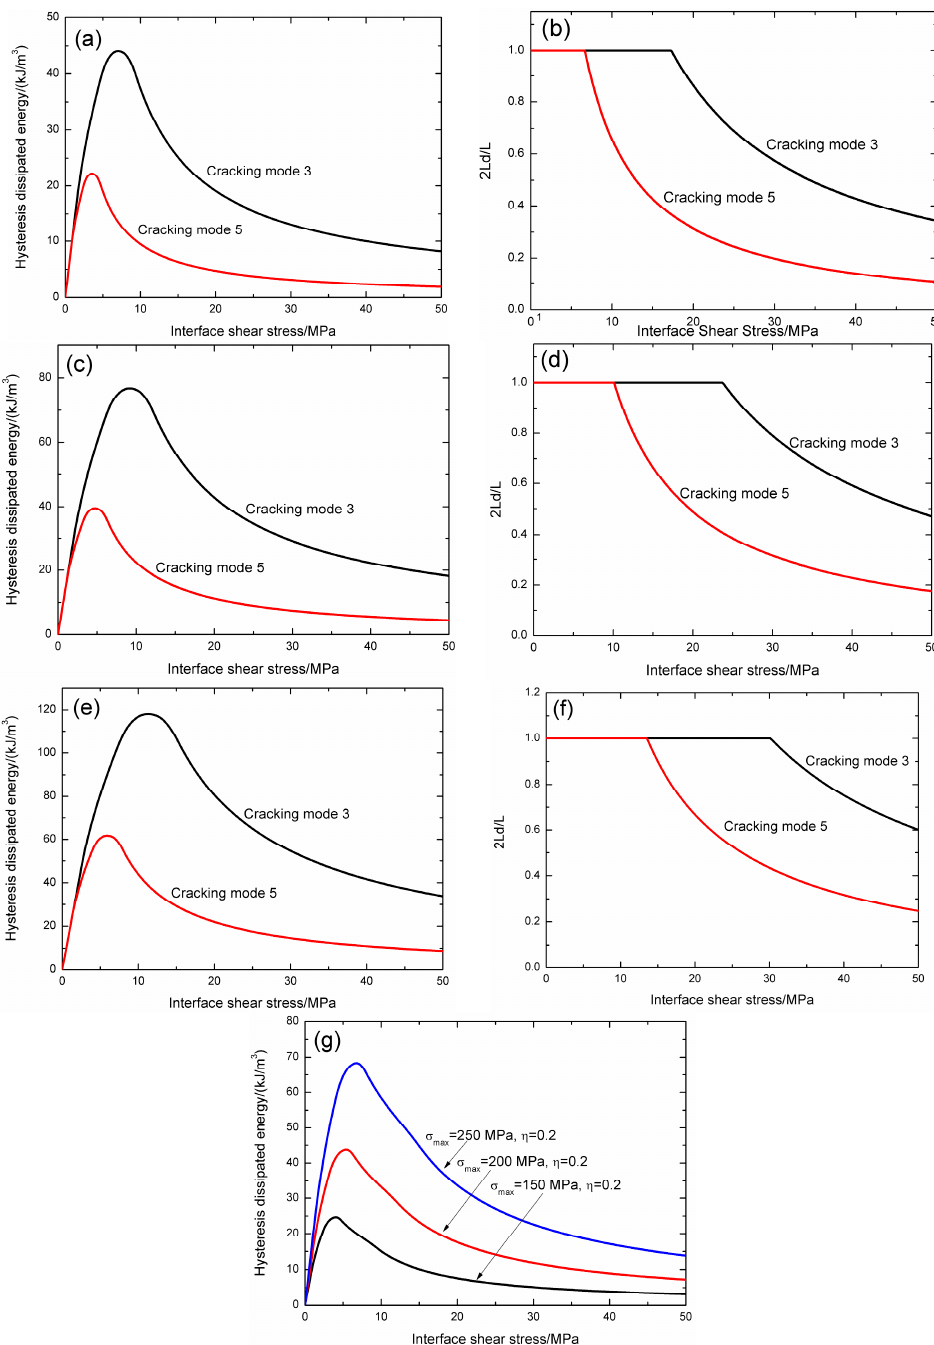
Figure 4. ( a ) The hysteresis dissipated energy versus interface shear stress curves of matrix cracking mode 3 and mode 5 when σ max = 150 MPa; ( b ) the interface debonded length 2 L d / L versus interface shear stress curves of matrix cracking mode 3 and mode 5 when σ max = 150 MPa; ( c ) the hysteresis dissipated energy versus interface shear stress curves of matrix cracking mode 3 and mode 5 when σ max = 200 MPa; ( d ) the interface debonded length 2 L d / L versus interface shear stress curves of matrix cracking mode 3 and mode 5 when σ max = 200 MPa; ( e ) the hysteresis dissipated energy versus interface shear stress curves of matrix cracking mode 3 and mode 5 when σ max = 250 MPa; ( f ) the interface debonded length 2 L d / L versus interface shear stress curves of matrix cracking mode 3 and mode 5 when σ max = 250 MPa; and ( g ) the composite hysteresis dissipated energy versus interface shear stress curves when σ max = 150, 200 and 250 MPa, and η =